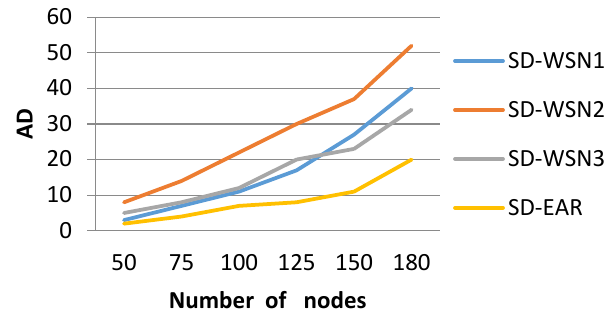
Figure 18. NT vs. number of nodes.